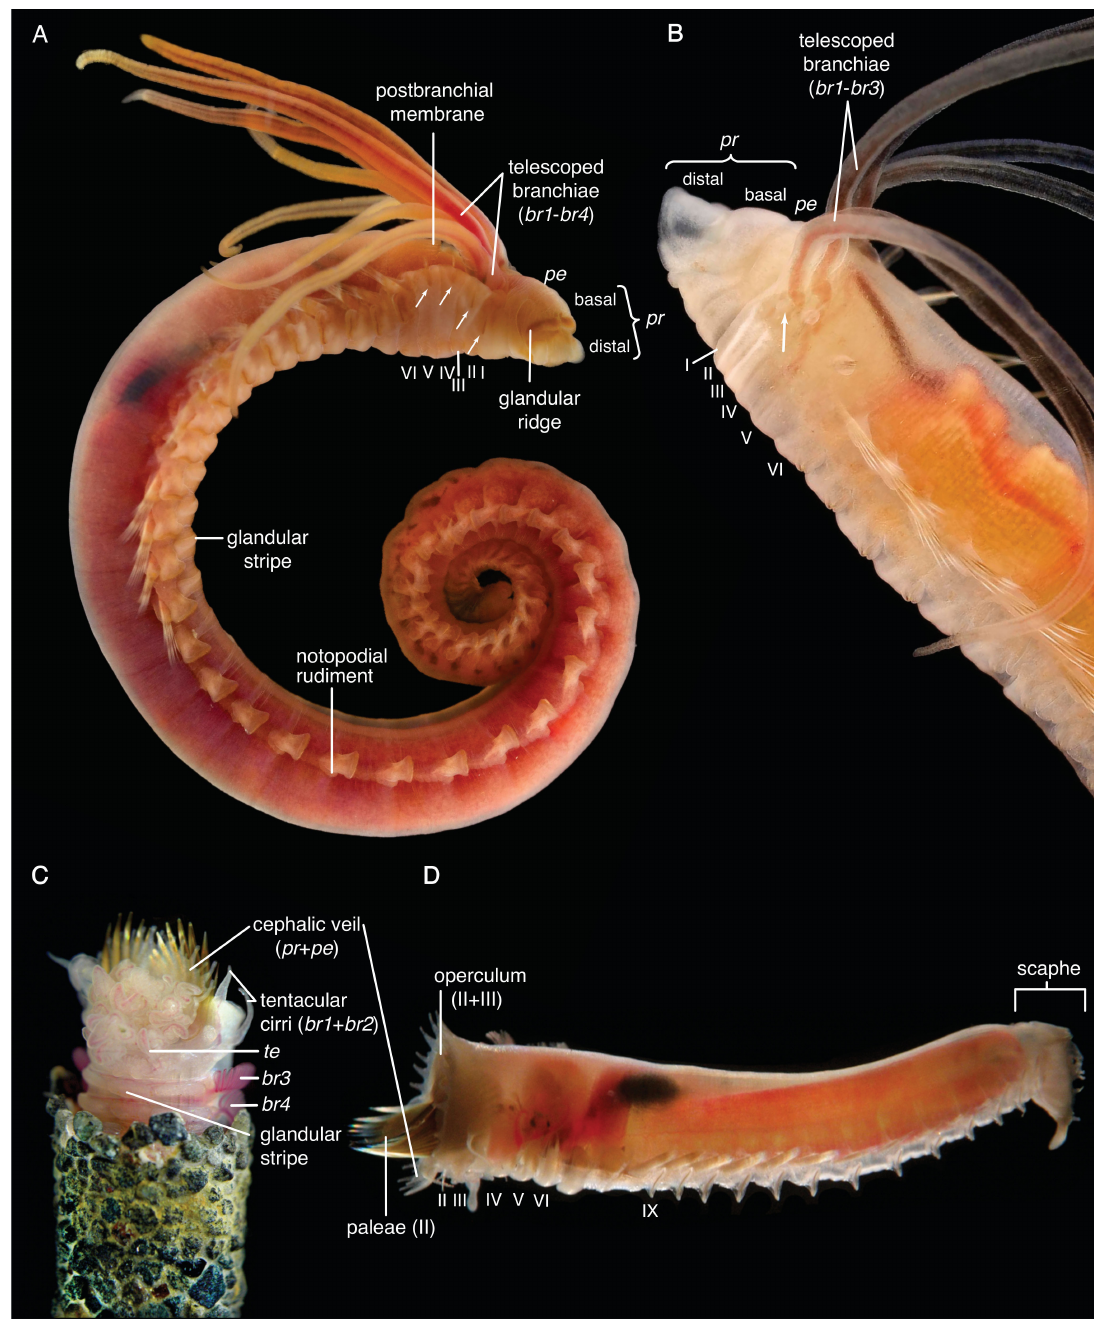
Figure A2. Morphology of Melinnidae, Ampharetidae and Pectinariidae. ( A ) Melinna albicincta (Melinnidae, SIO-BIC A1113), arrows point towards the neuropodial aciculae on the ventro-lateral collar. ( B ) Samytha sexcirrata (Ampharetidae, Ampharetinae, SIO-BIC A1110) anterior body, the arrow points to the small notopodial spines (paleae) on Segment II. ( C ) Pectinaria granulata (Pectinariidae, SIO-BIC A9441), ventral view of head emerging from tube. ( D ) Pectinaria auricoma